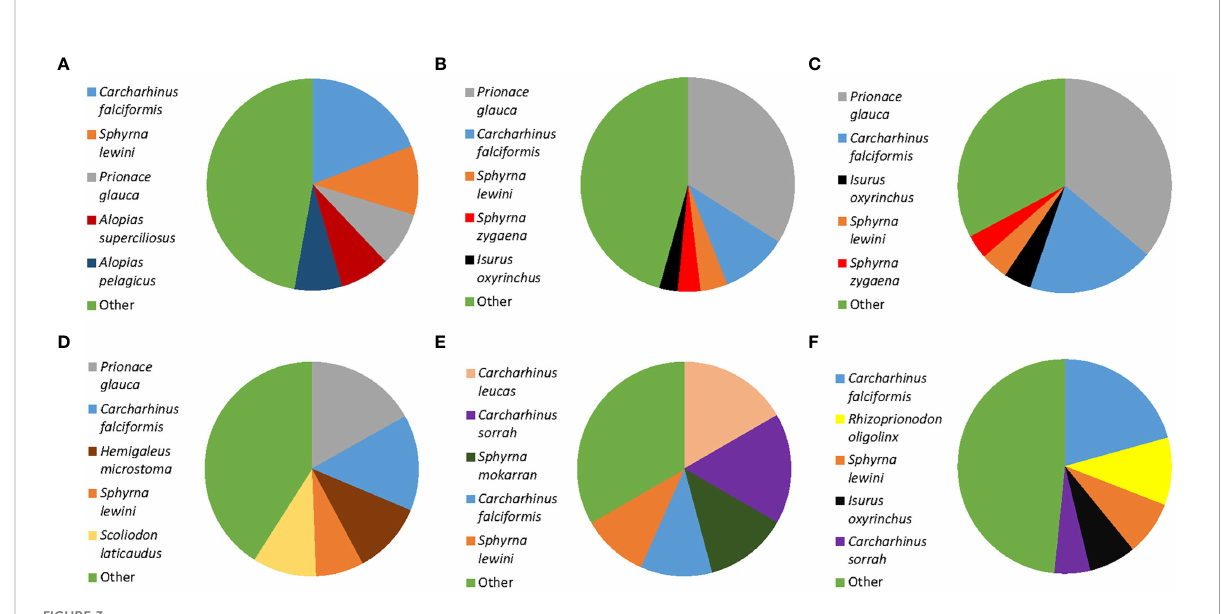
FIGURE 3 Comparison of shark fi n DNA barcoding projects showing the top fi ve most frequently occurring shark species in each study. Only identi fi cations to the species level are included. (A) Sembiring et al., 2015, Indonesia. (B) Fields et al., 2018, Hong Kong. (C) Wainwright et al., 2018, Singapore. (D) Cardeñosa et al., 2020, Mainland China. (E) Seah et al., 2022, Malaysia. (F) This study, Singapore. The category ‘ Other ’ includes all species that are found at a low frequency, see cited studies for exact proportions of the species included in this